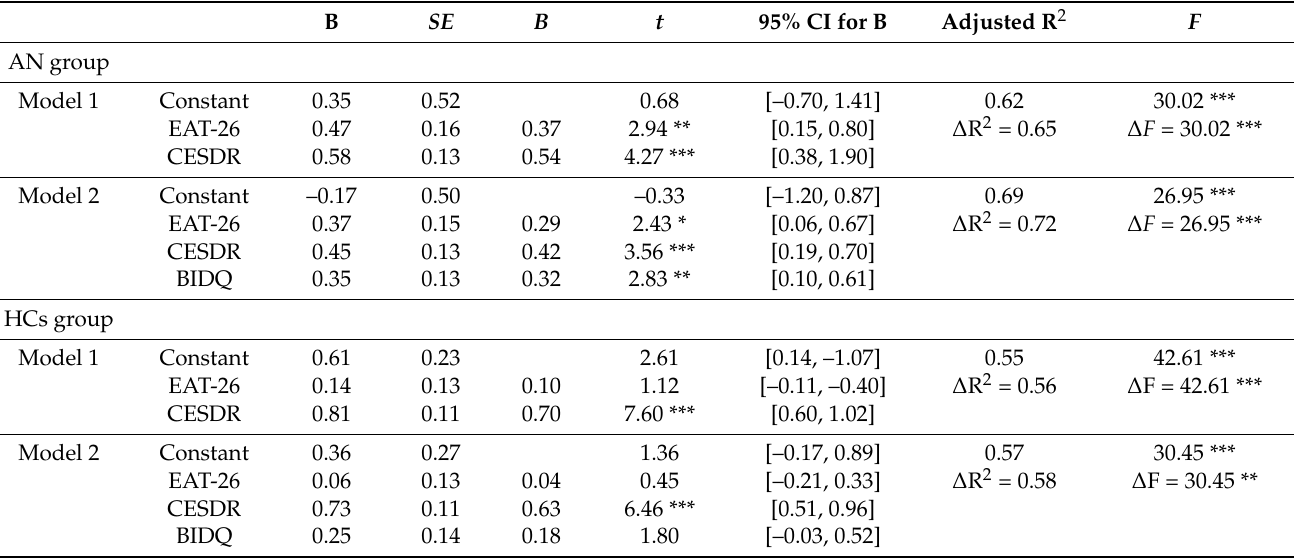
Table 3. Hierarchical regression analysis predicting mental pain intensity from distorted body image after controlling for the level of eating disorders and depression